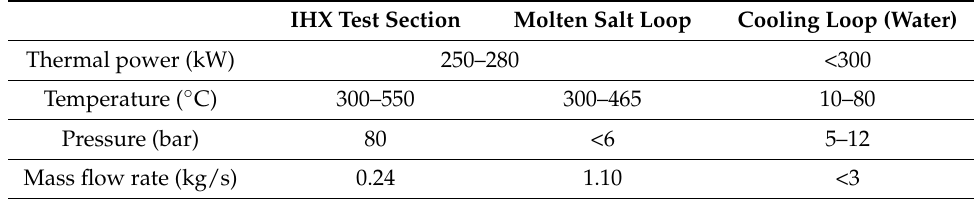
Table 3. Main data for HELOKA-US